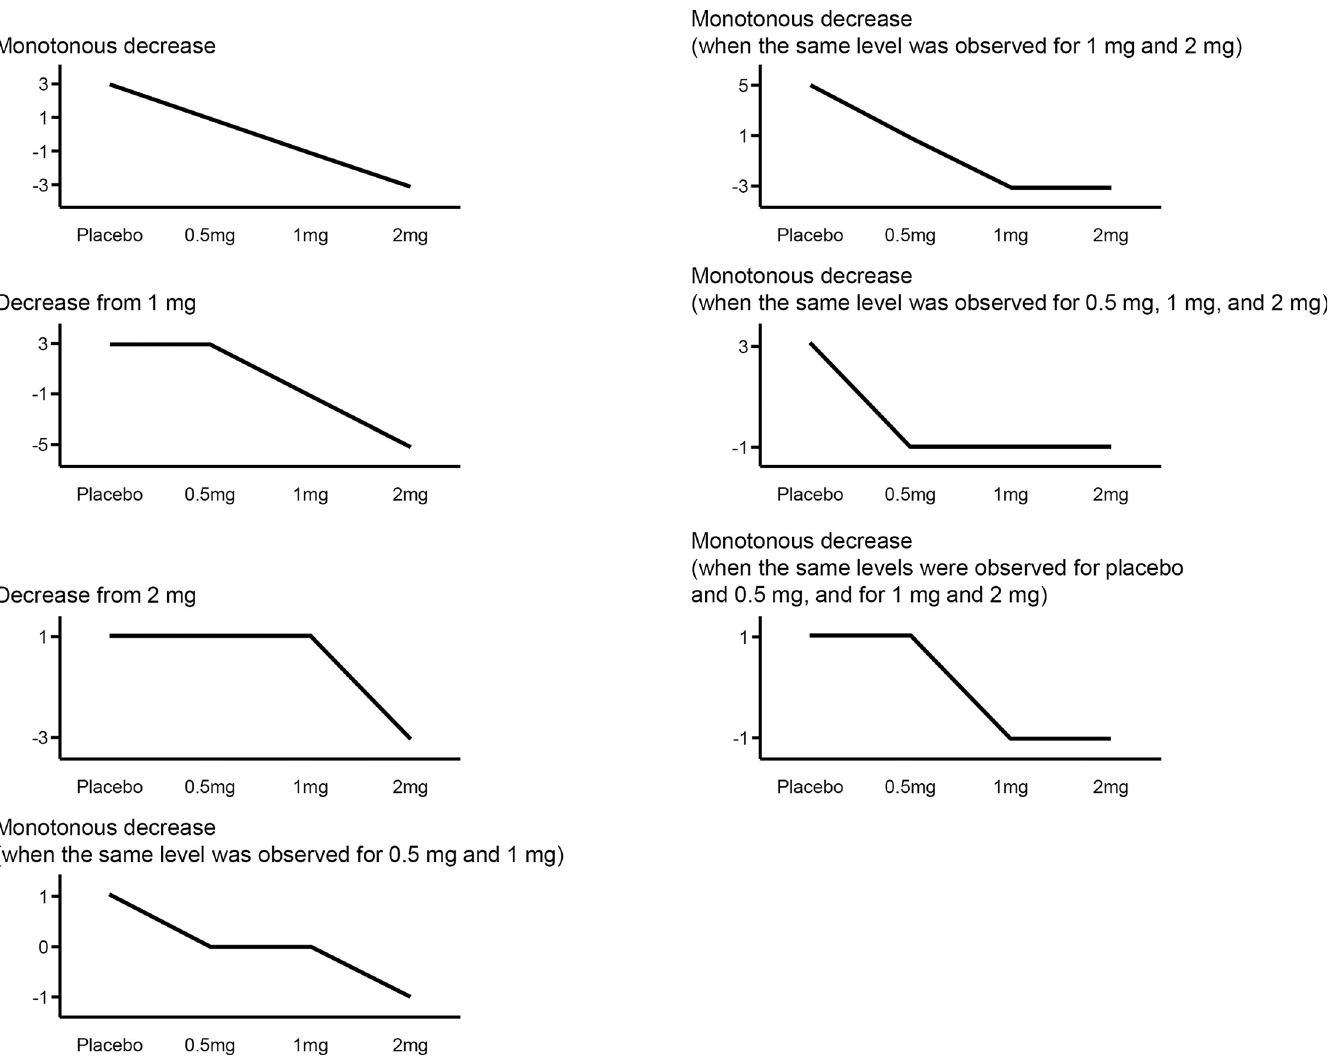
Fig 4. Contrast patterns used for the dose-response profile of evocalcet. The dose-response profile was examined using seven types of contrast patterns involving the respective mean values in the evocalcet 0.5, 1, and 2 mg and placebo groups. The contrast coefficients are displayed on the y-axis of each graph.